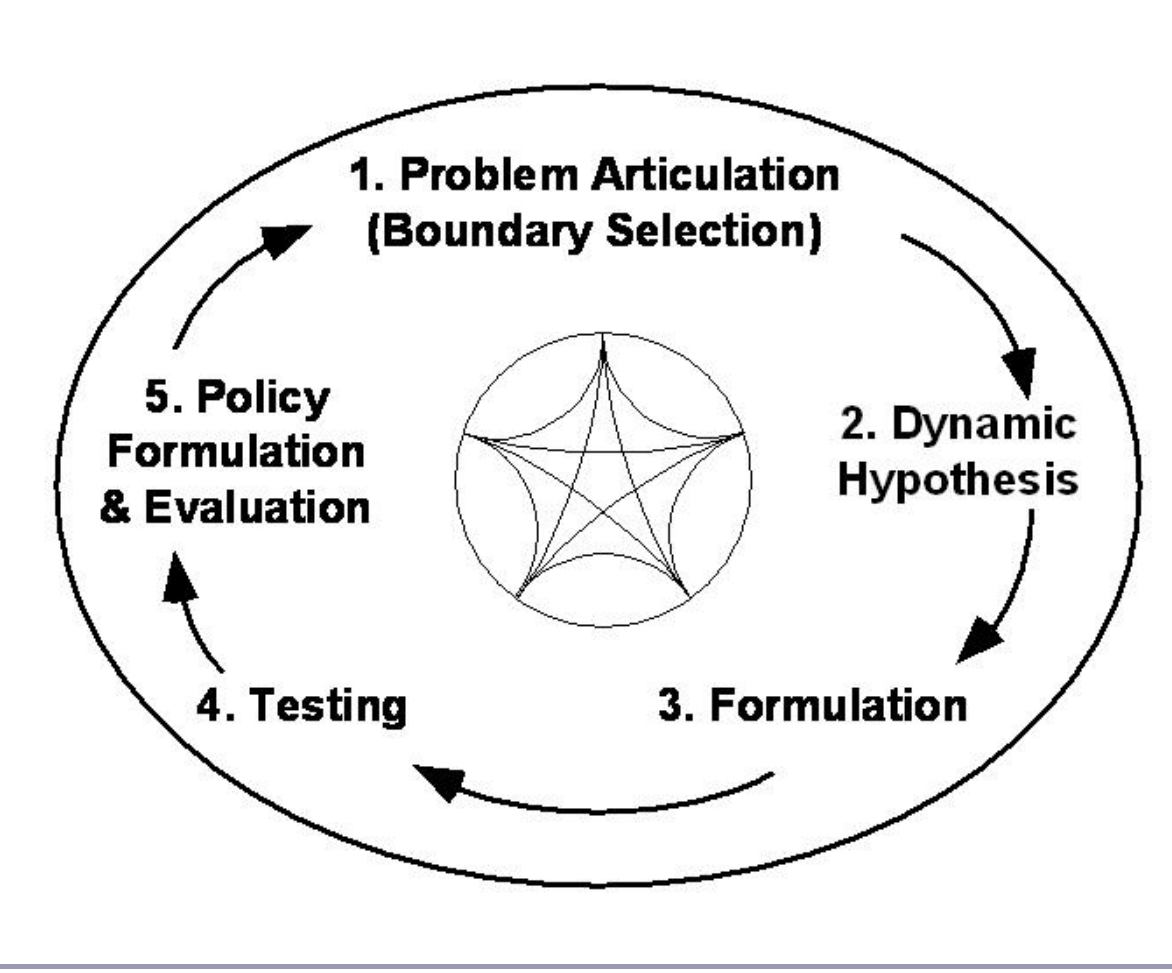
Fig. 1 . Iterative process of model development linked to policy formulation whose evaluation stimulates reassessment of the problem (after Sterman